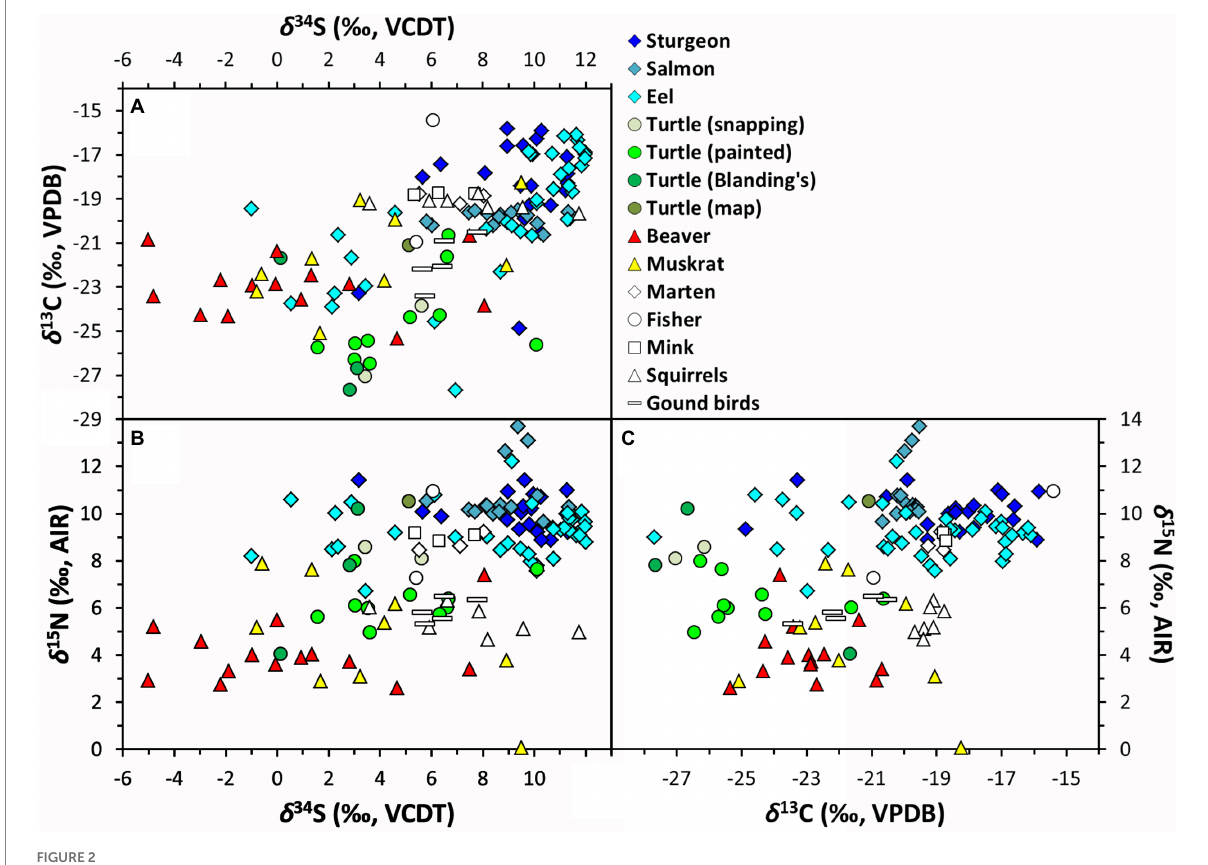
FIGURE 2 (A–C) Stable isotope compositions of archaeological